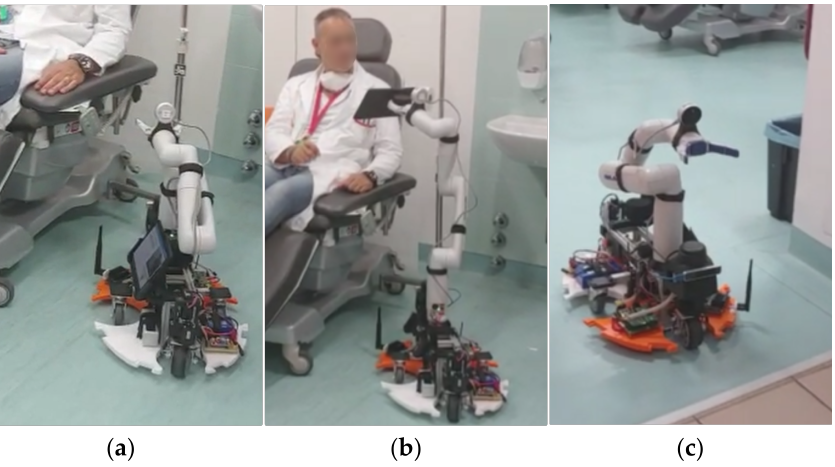
Figure 9. D.O.T. PAQUITOP mobile manipulator during the validation test at the hematology ward, Molinette Hospital: ( a ) D.O.T. PAQUITOP approaching the transfusion seat; ( b ) D.O.T. PAQUITOP interacting with the patient; ( c ) D.O.T. PAQUITOP navigating through the hospital